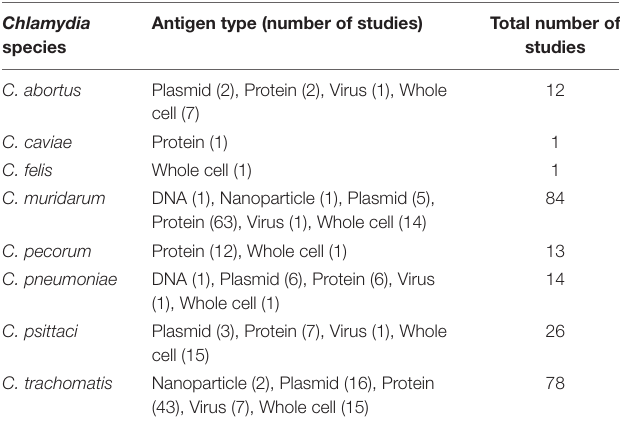
TABLE 3 | Chlamydial species and the different types of antigens used in